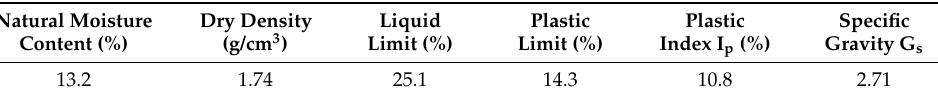
Figure 2. Particle size distribution curves: ( a ) differential particle size distribution curves; ( b ) cumu- lative particle size distribution curves. Table 1. Main physical properties of the loess.